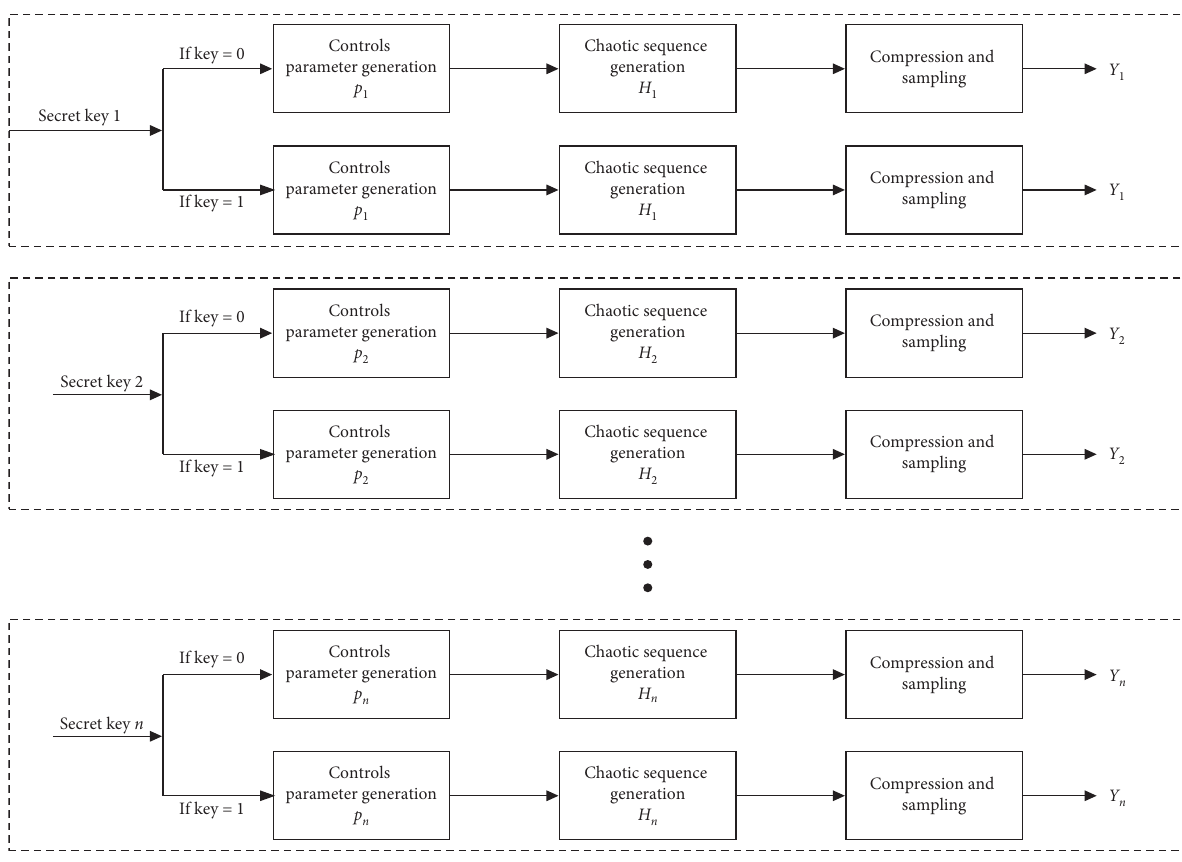
Figure 4: Parallel sampling compression of compressed sensing